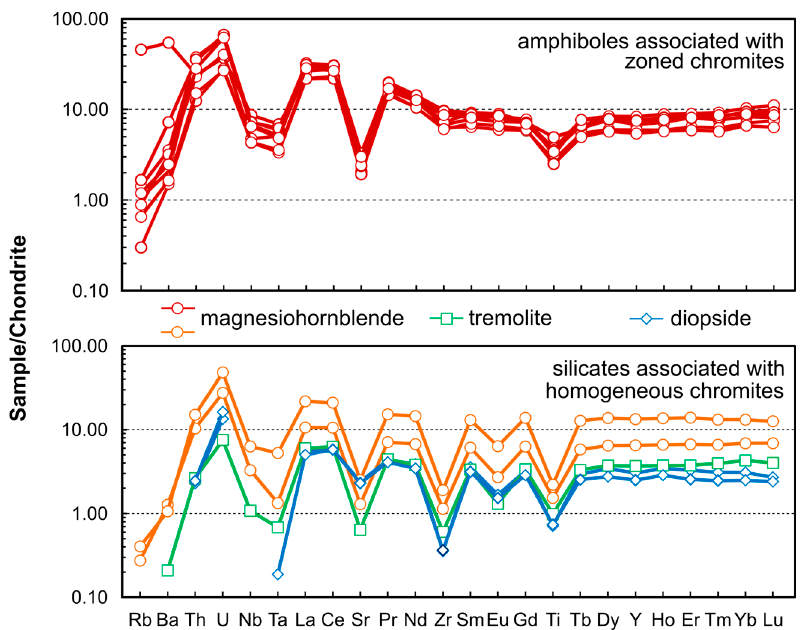
Figure 8. Chondrite-normalized trace element concentration of the amphiboles and clinopyroxenes of the Ulamertoq samples. Normalizing values are from Sun and McDonough [41].